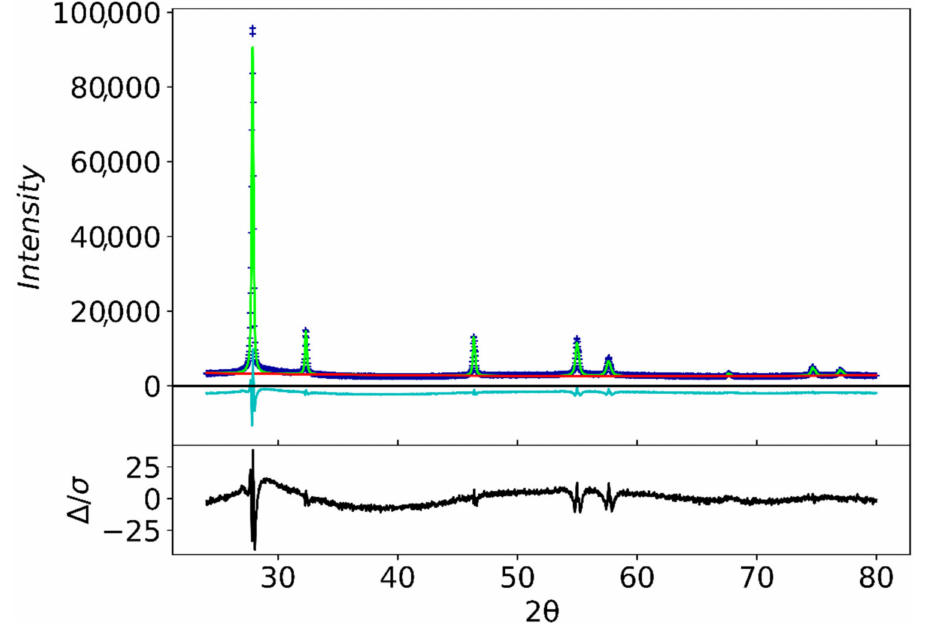
Figure 2. Representative phase matching performed by the Rietveld method for the sample melted at 1000 ◦ C, quenched by the twin rollers technique at 1000 RPM. Blue points (+) are the experimental data; red—the background function; green—the fitted fluorite phase model. Turquoise bottom line is a difference plot and black plot shows the weighted difference between the observed and calculated diffraction runs. Table 1. Results of calculations by the Rietveld method for samples melted at 900 ◦ C. Sample